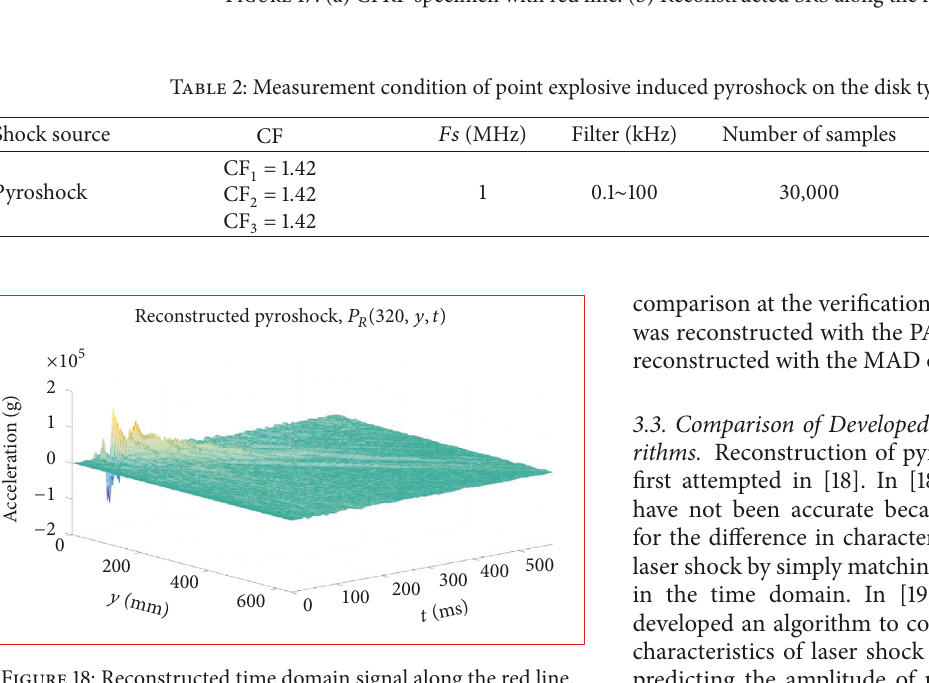
Figure 17: (a) CFRP specimen with red line. (b) Reconstructed SRS along the red line.